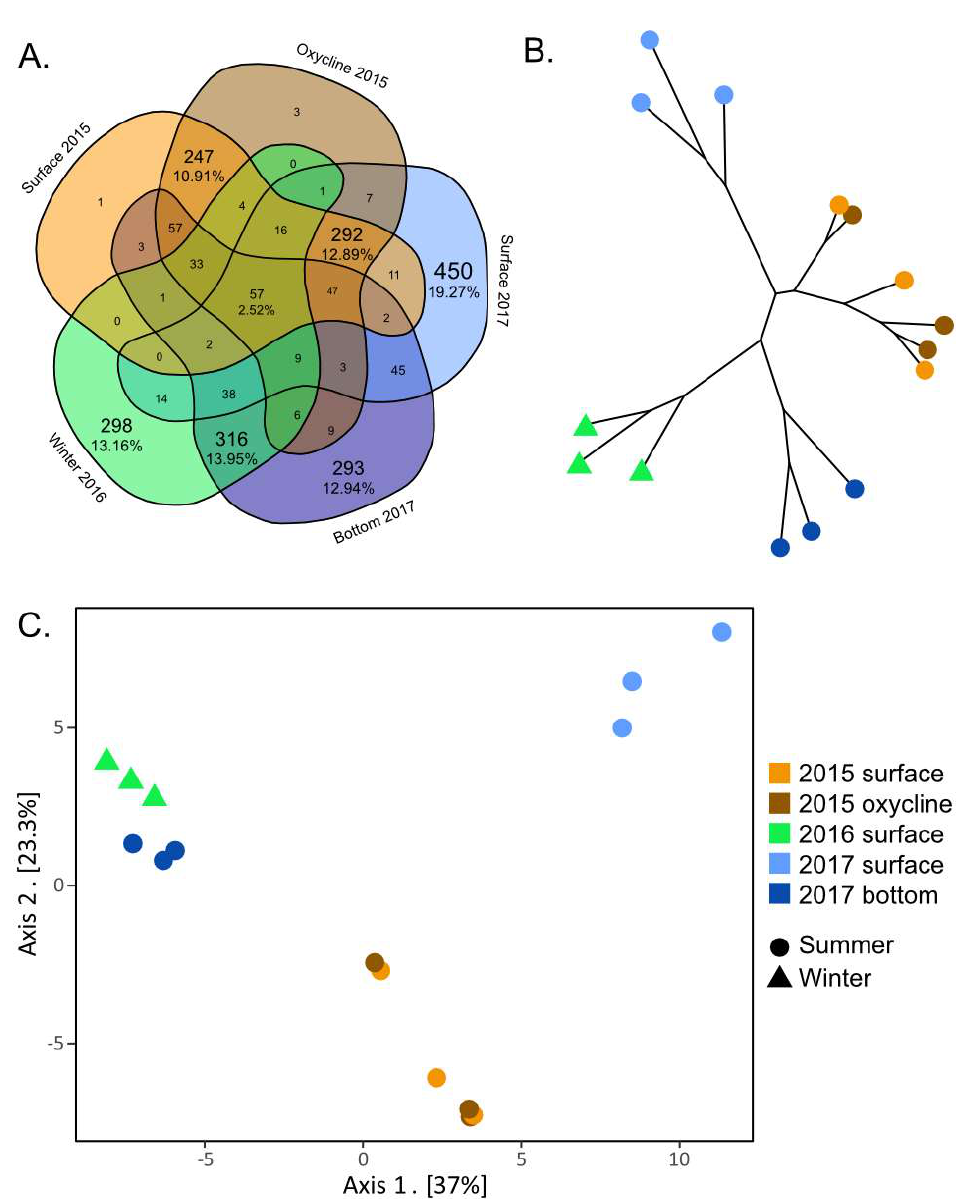
Figure 4. Representation of beta diversity of viral communities from the SAS2A lake. Beta diversity is represented using ( A ) a Venn diagram, ( B ) a neighbor-joining tree and ( C ) a principal coordinates analysis (PCoA) graph. The neighbor-joining tree and PCoA graph were both made using the Euclidean distance between viral communities.